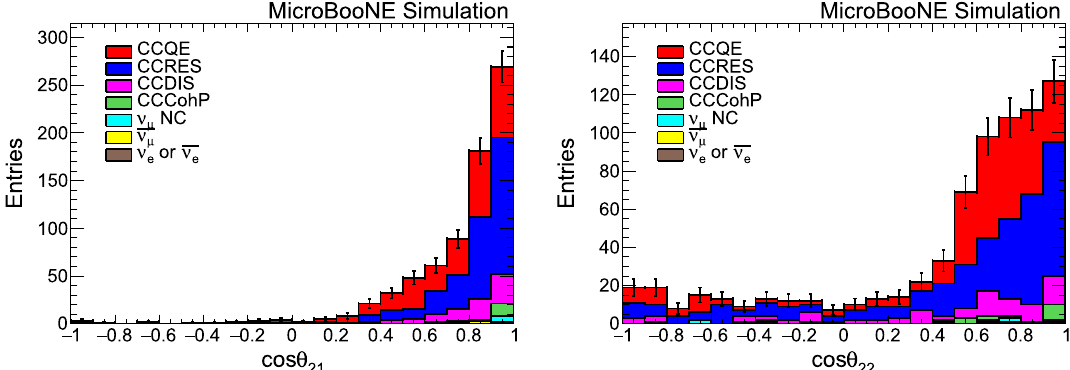
Fig. 31 Multiplicity = 2 cosine of polar angle distribution for candidate muon (left); for second track (right) from GENIE default MC. Black error bars represent MC statistical uncertainties